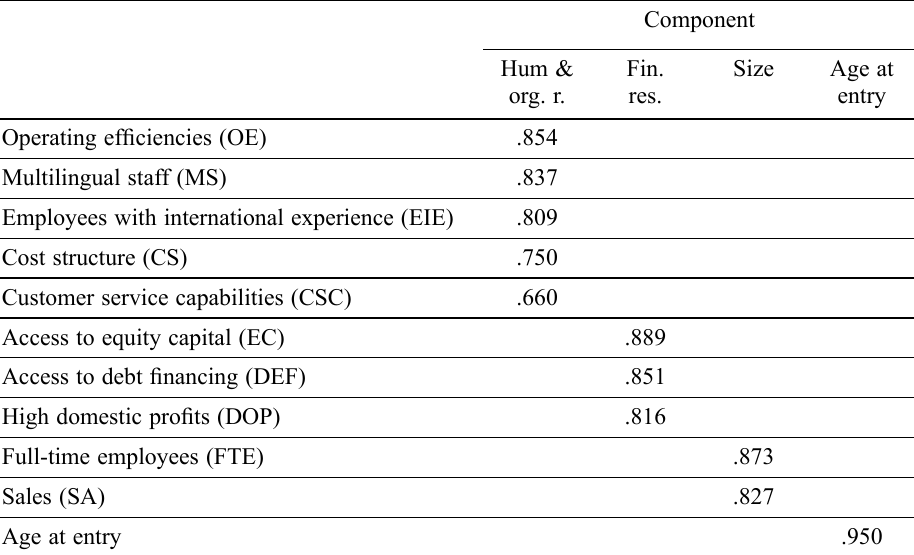
Table 2. Factor analysis results with item factor